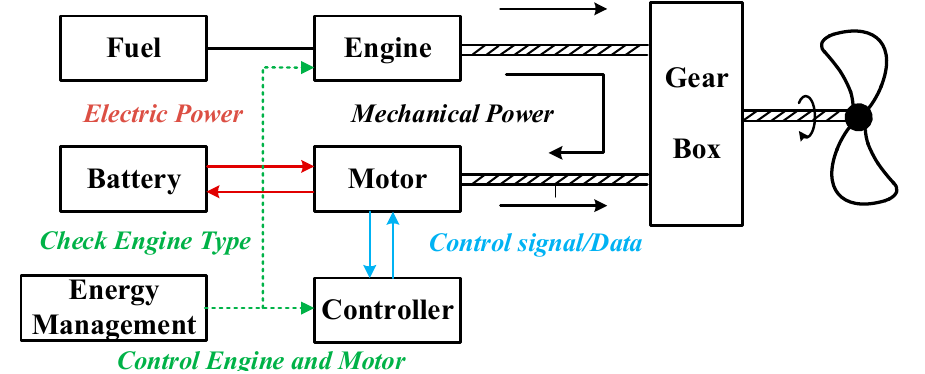
Figure 11. Parallel hybrid architecture.